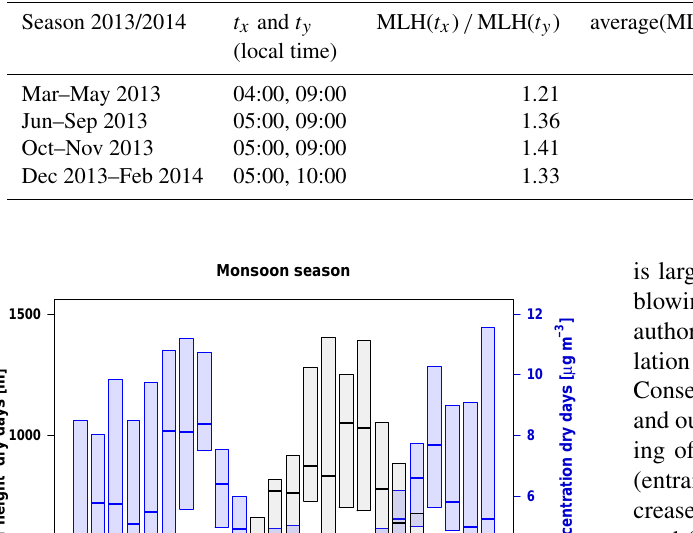
Table 2. Terms for the estimation of the BC emission flux as used in Eq. (3) and estimated BC emission flux for four seasons during the period March 2013 to February 2014.